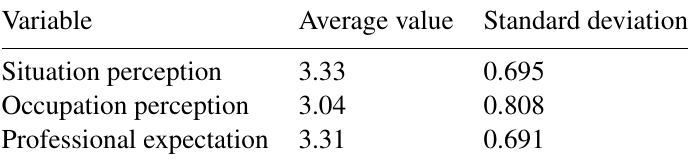
Table 7 Descriptive statistics of professional attitude dimensions.